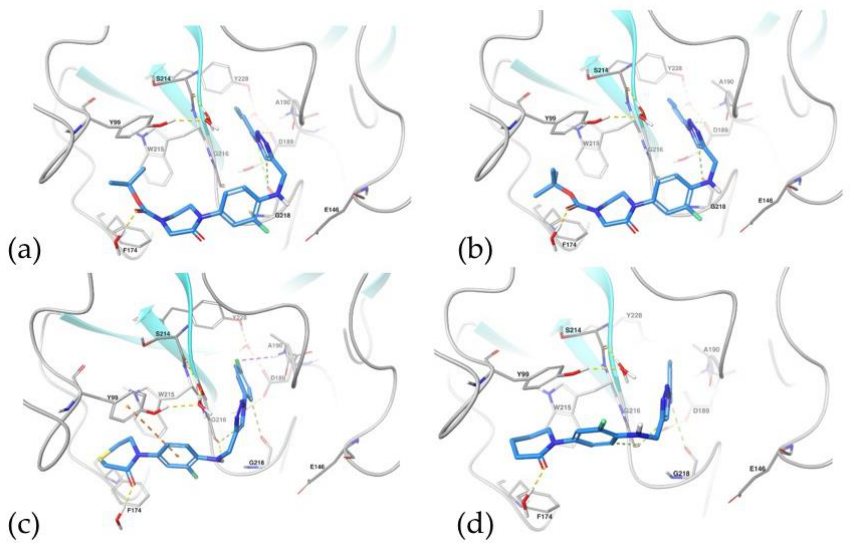
Figure 11. Molecular docking of structures 31 , 30 , 34 , and 27 (( a ), ( b ), ( c ), and ( d ), respectively) into the active site of FXa enzyme (PDB: 2HYY). The dotted lines show the most common ligand-protein interactions in all ligand binding poses, HB in yellow, π - π stacking in orange, halogen bond in magenta and CH ··· O HB in